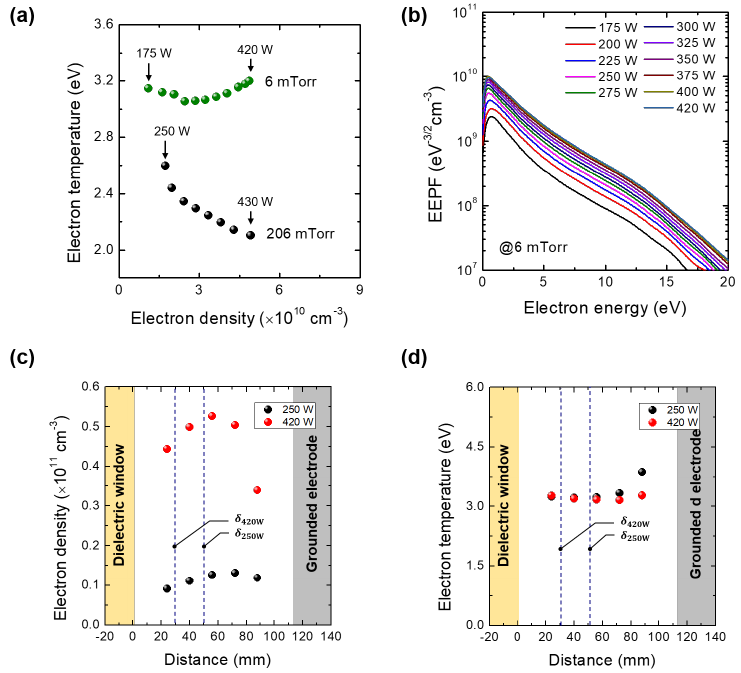
Figure 5. ( a ) Measured electron temperature (T e ) over the measured electron densities with various discharge powers at 6 mTorr and 206 mTorr: at 6 mTorr, discharge power was varied from 175 to 420 W with 25 W increment and at 206 mTorr, from 250 W to 430 W with 25 W increment. ( b ) Electron energy probability function (EEPF) with various discharge powers at 6 mTorr. The Langmuir probe position is 58 mm, which is the center between the dielectric window (Al 2 O 3 ) and the grounded electrode. ( c ) Electron density and ( d ) temperature profiles with discharge powers of 175 W and 420 W at 6 mTorr. The average skin depths ( δ 175W of 50.7 ± 3.34 mm and δ 420W of 25.5 ± 2.22 mm) are marked as the dashed